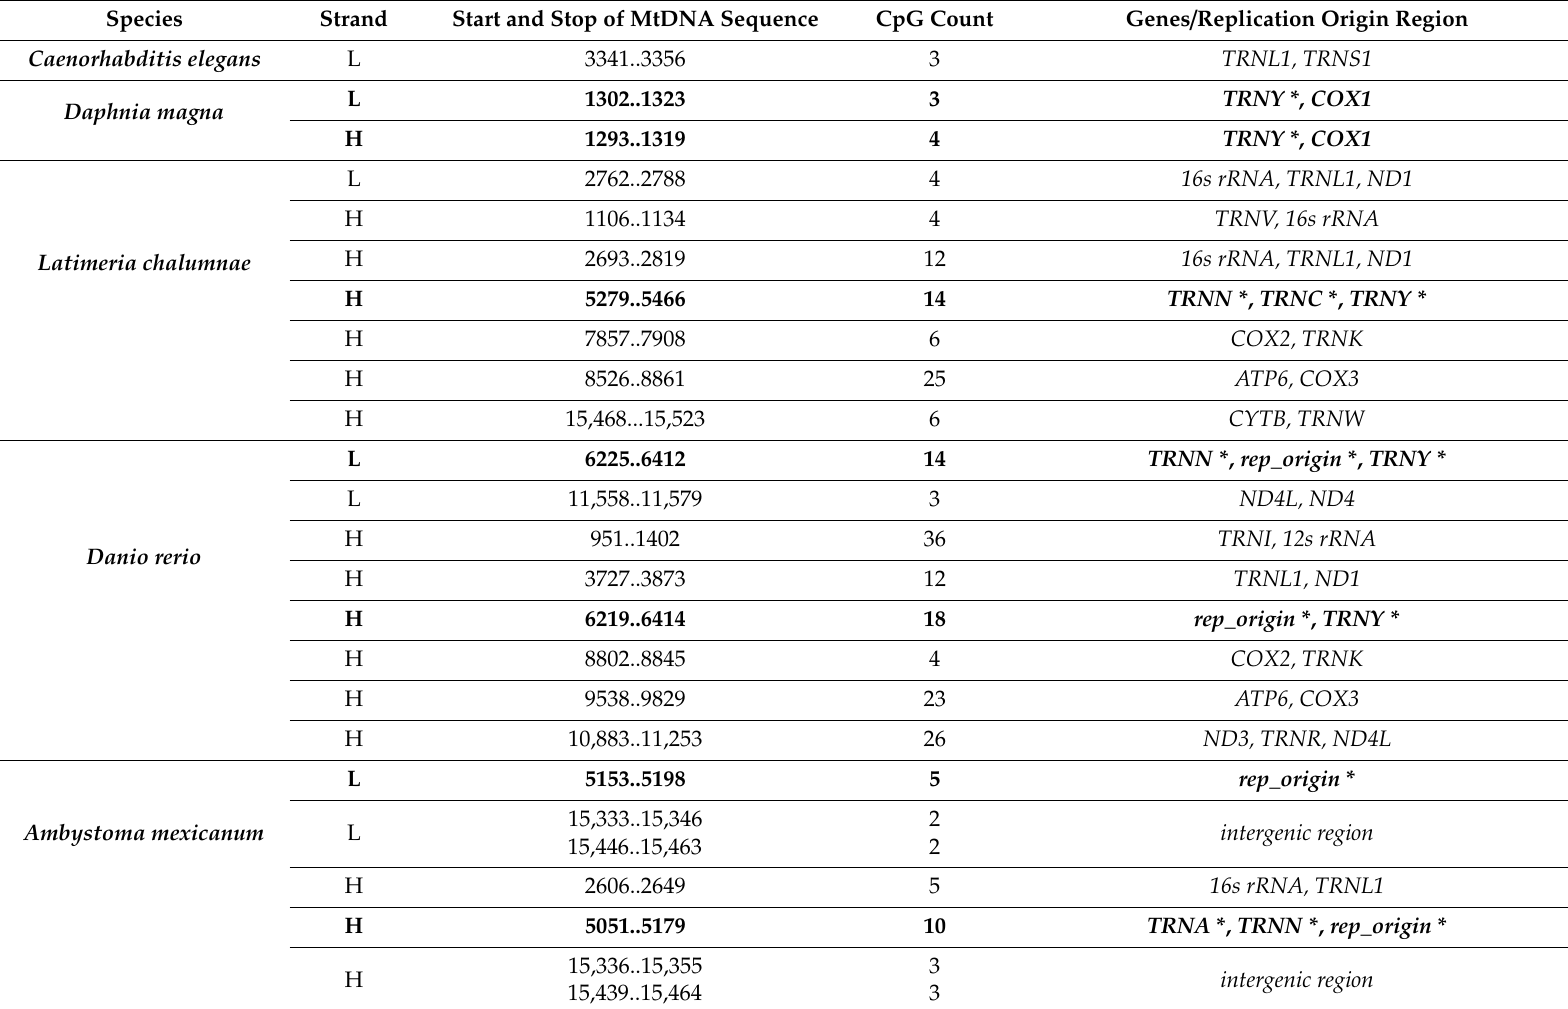
Table 5. Distribution of CpG sites in regions overlapping more than one gene in mtDNA.